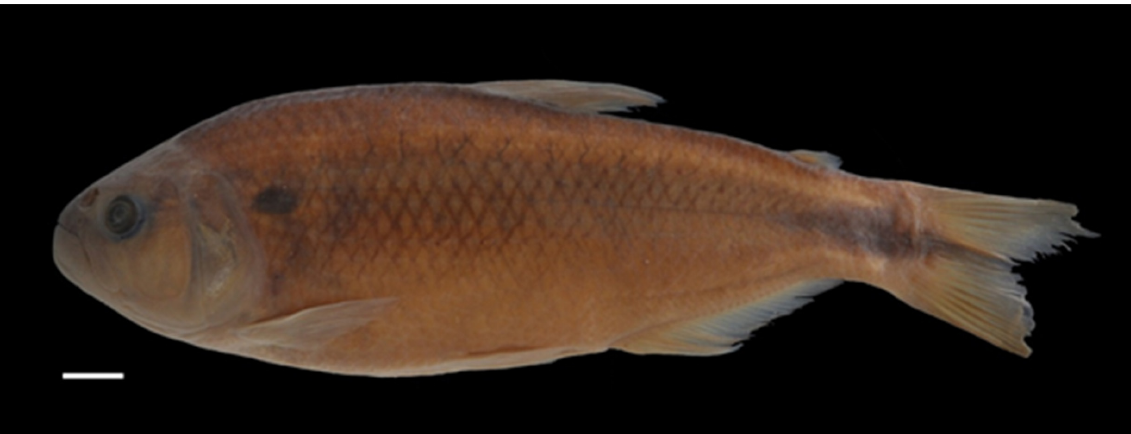
Fig. 7. Astyanax bopiensis nom. nov., 143.9 mm SL, Quebrada Culli, Madre de Dios River drainage, Upper Amazon, Peru (MUSM 3758). Scale bar =